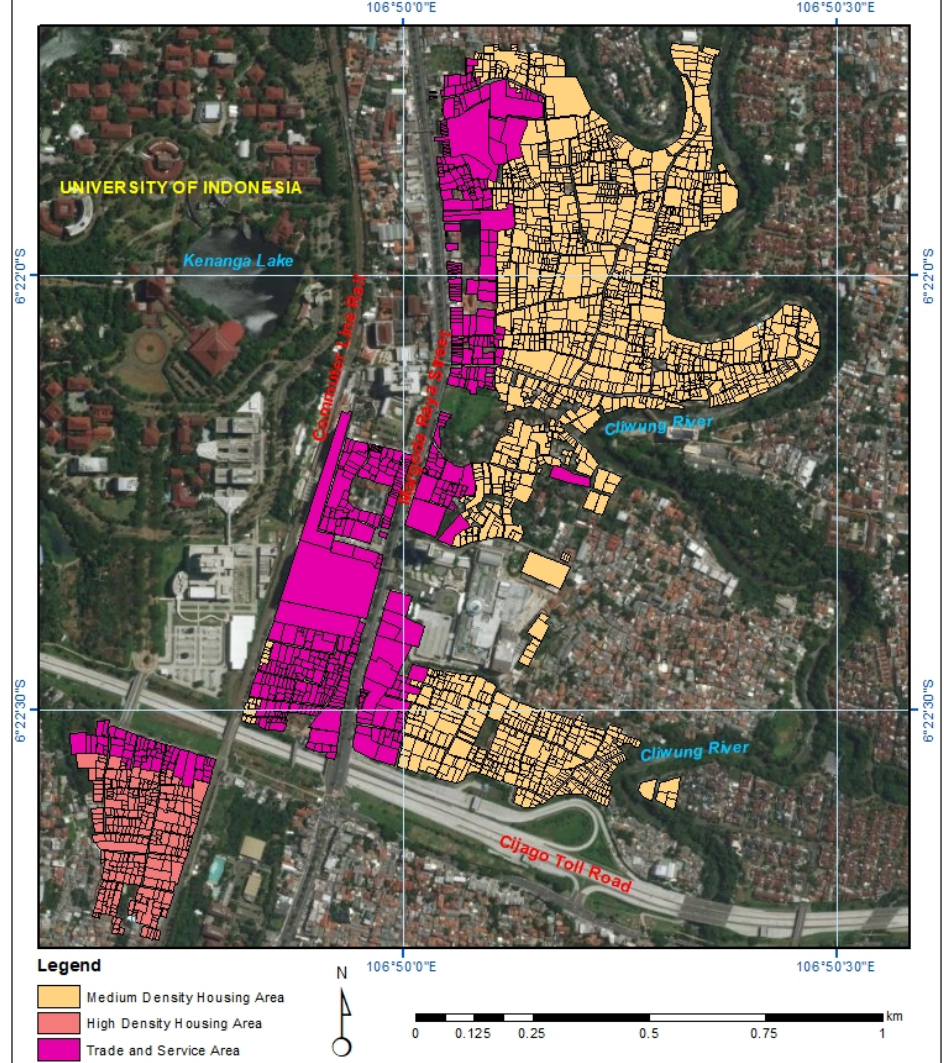
Figure 1. Map of the study area.